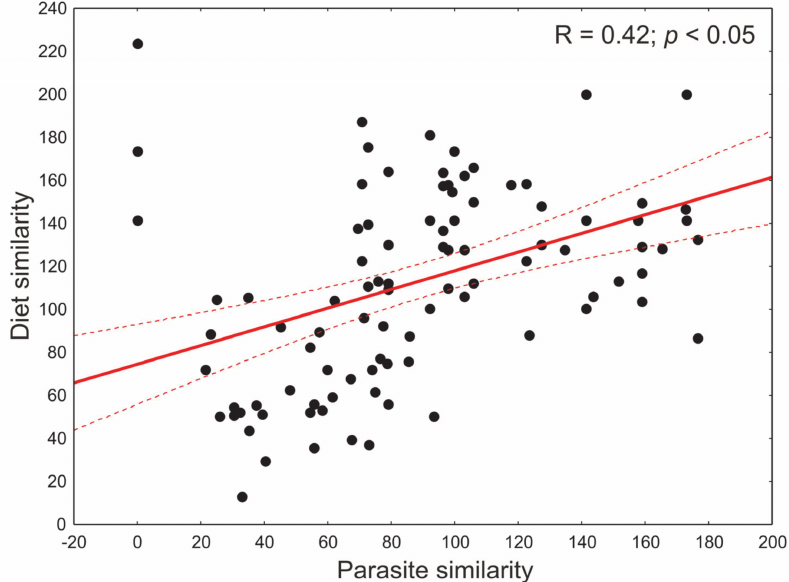
Figure 3. Results of the Mantel test. The correlation between cats’ diet similarity and parasite similarity. Pearson correlation coe ffi cient as well as regression line with 95% confidence interval are